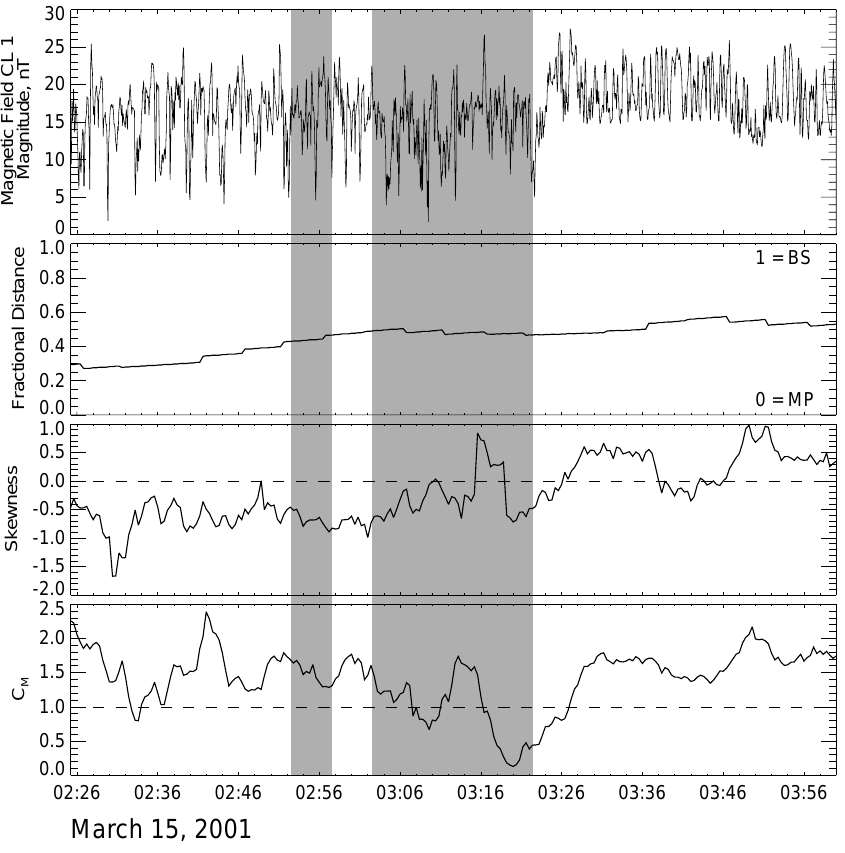
Fig. 2. Observations of mirror structures by Cluster 1 on 15 March 2001. From top to bottom: magnetic field amplitude, fractional distance F , skewness of magnetic fluctuations and mirror parameter C M . The grey color codes windows of 5min when mirror structures are not detected by the algorithm based on magnetic